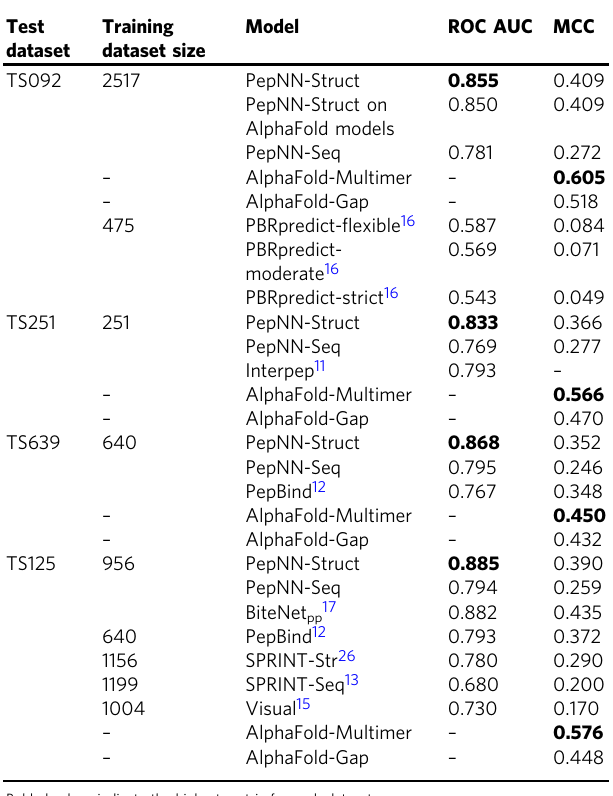
Table 1 Comparison of the developed model to existing